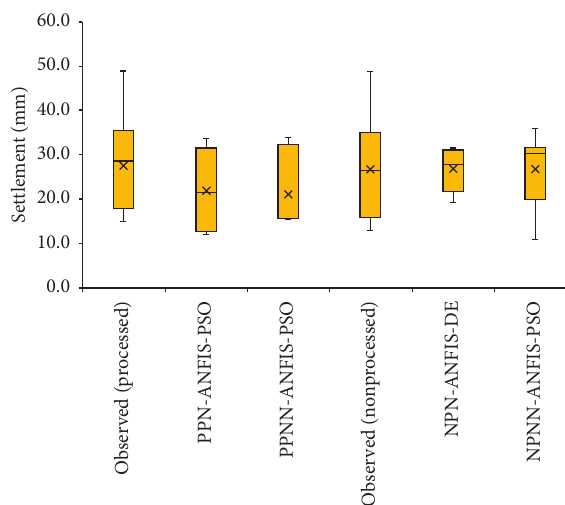
Figure 8: The box plots presentation of the observed and predicted settlement over the testing phase.